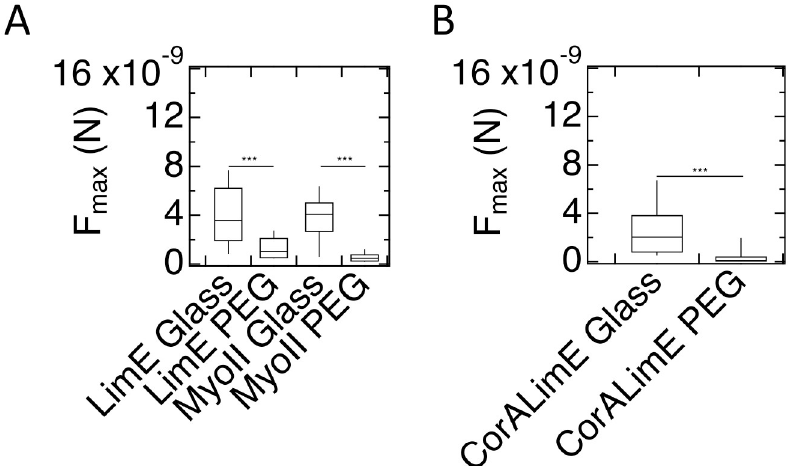
Fig 9. Maximum force of adhesion for developed cells with cytoskeletal labeling. A) AX2 cells with the specified on PEG-gel surfaces compared to glass. B) As in A), but now cytoskeletal markers exhibit significantly reduced F max for AX4 cells. F max on PEG-gel surfaces is significantly less than on